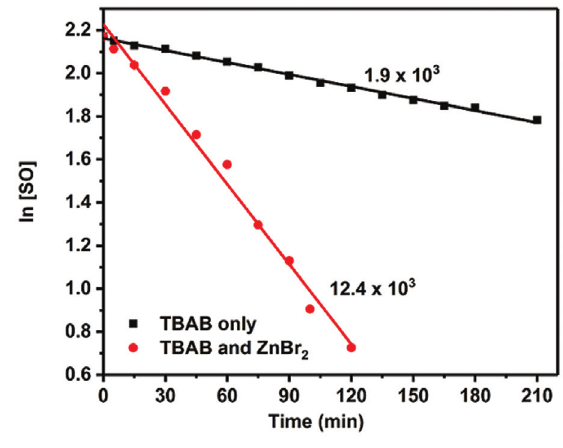
Figure 7: Rate of styrene carbonate (SC) formation catalysed by TBAB with and without ZnBr ZnBr /TBAB (1:4), 100°C and 6 bar p (CO 2